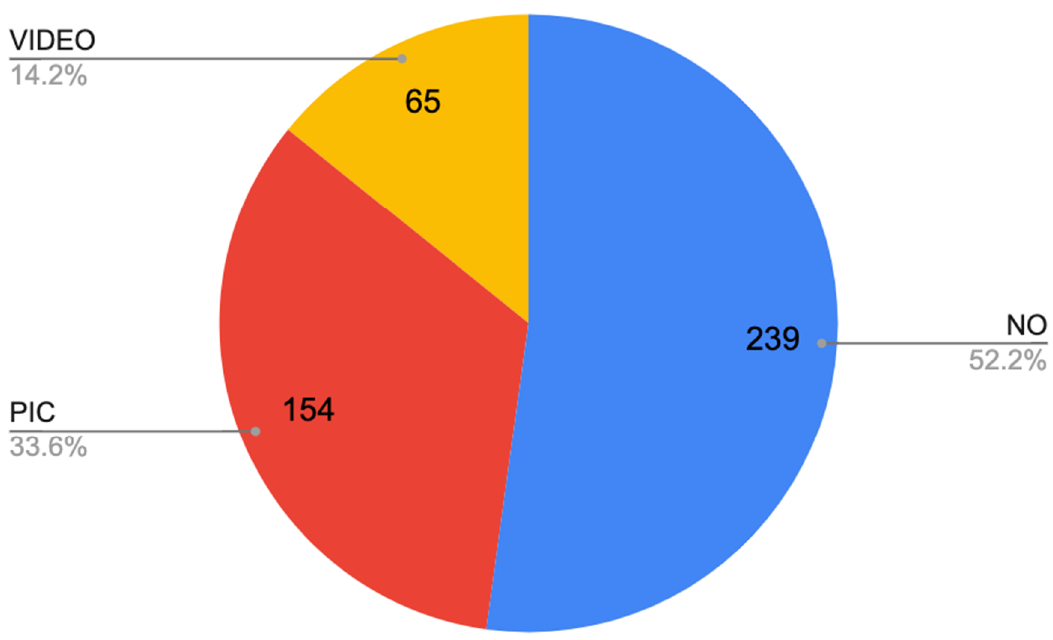
Figure 8. Tweets by attached. Source: Own elaboration.